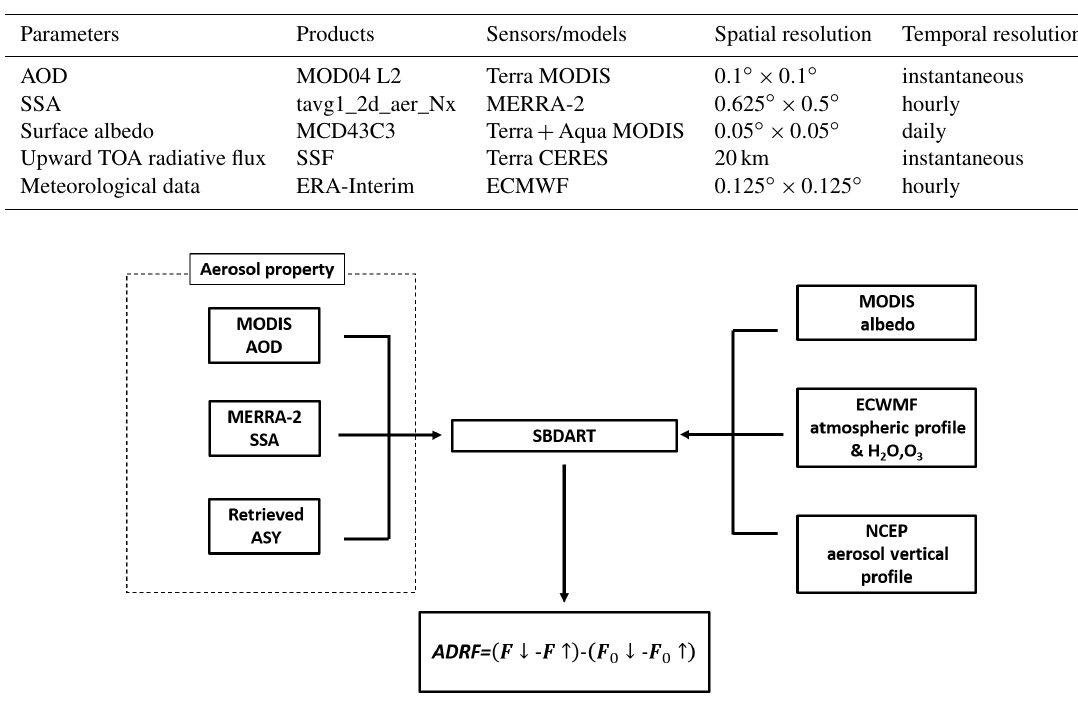
Figure 2. A schematic diagram to simulate ADRF based on satellite and reanalysis